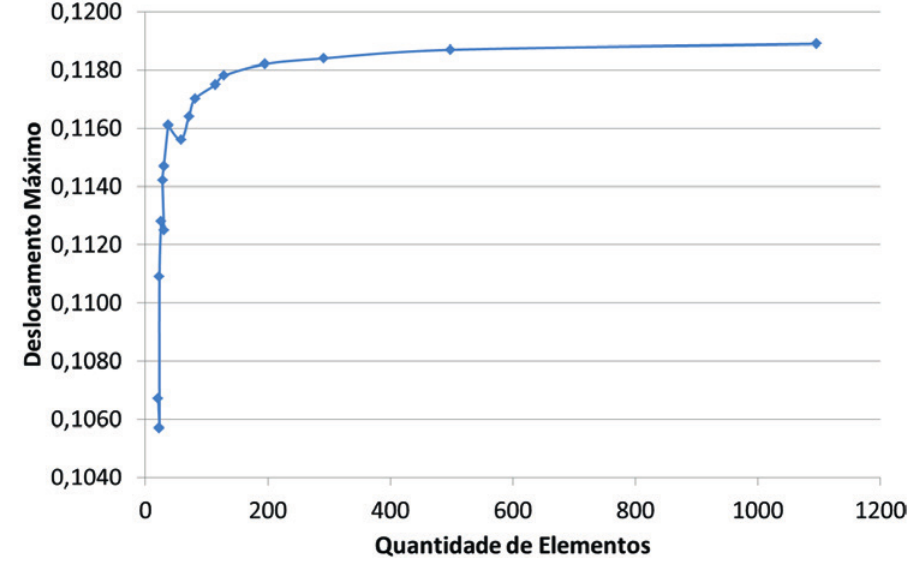
Deslocamento máximo x quantidade de